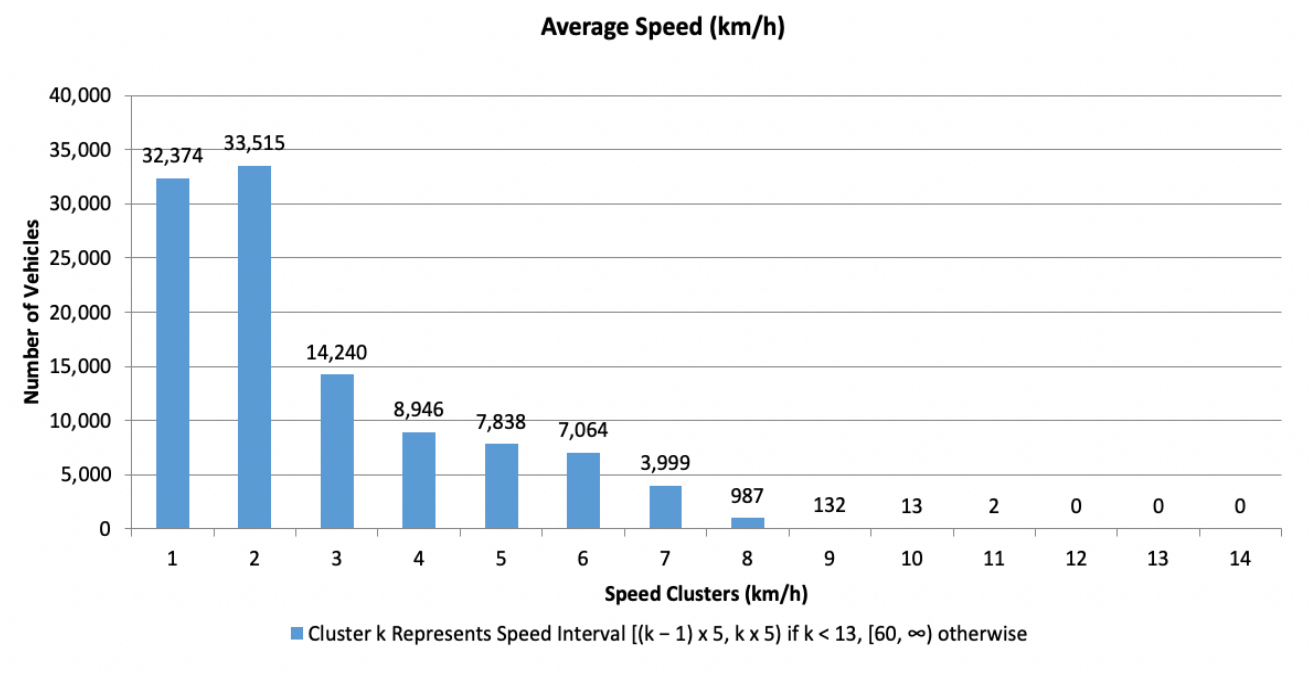
Figure 11. Speed distribution in clusters for 100 K+ simulated vehicles in Bucharest with δ =